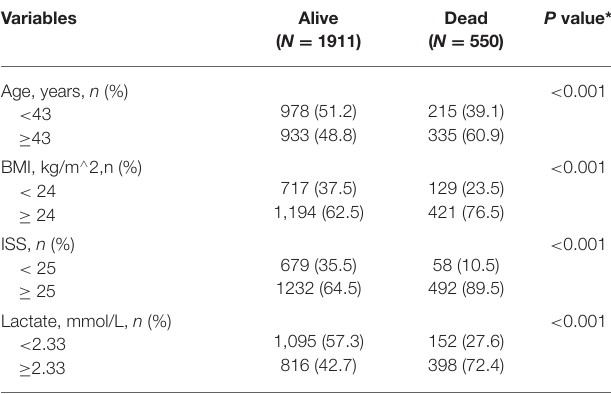
TABLE 4 | A logistic regression analysis of the 72-h mortality for patients in the training cohort.